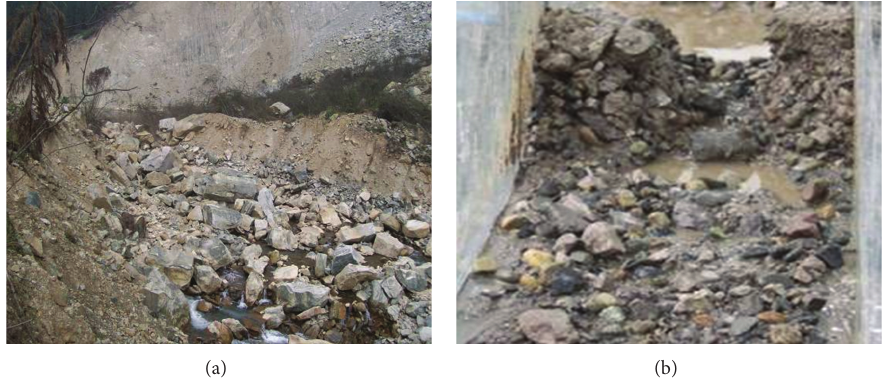
Figure 20: Dam break patterns for the landslide dam: (a) actual situation and (b) experimental